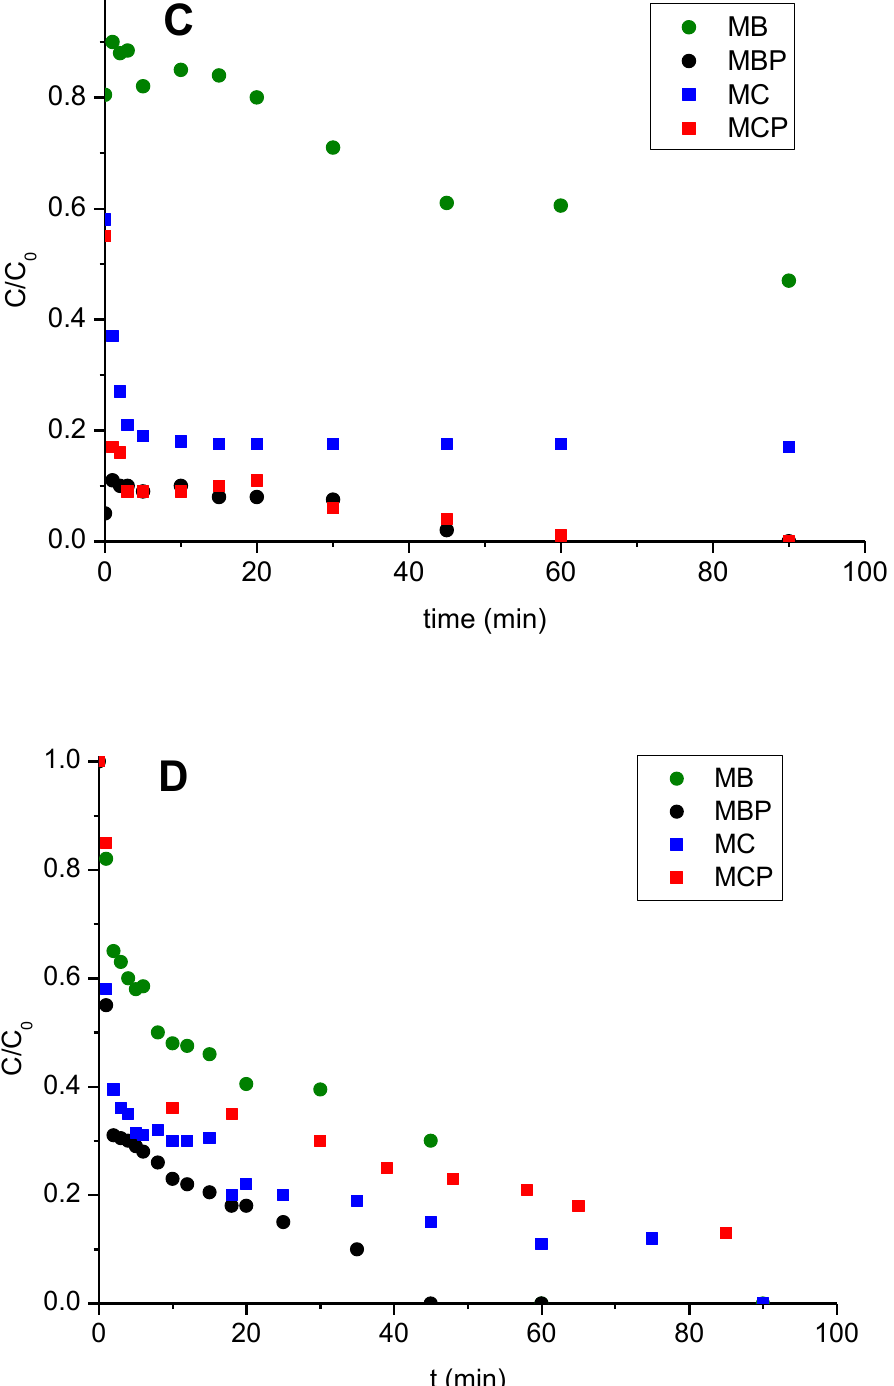
Figure 5. DCF concentration (C 0 = 20 mg L − 1 ) profiles measured for the four materials under study at di ff erent experimental conditions. ( A ) In the presence of only materials. ( B ) In the presence of materials and under irradiation. ( C ) In presence of materials and stoichiometric H 2 O 2 amount. ( D ) In presence of materials, stoichiometric H 2 O 2 amount and under irradiation. Data reported consider a final concentration of materials of 500 mg L − 1 and a final time of 90 min. Legend: MB green circles, MBP black circles, MC blue squares, MCP red squares.